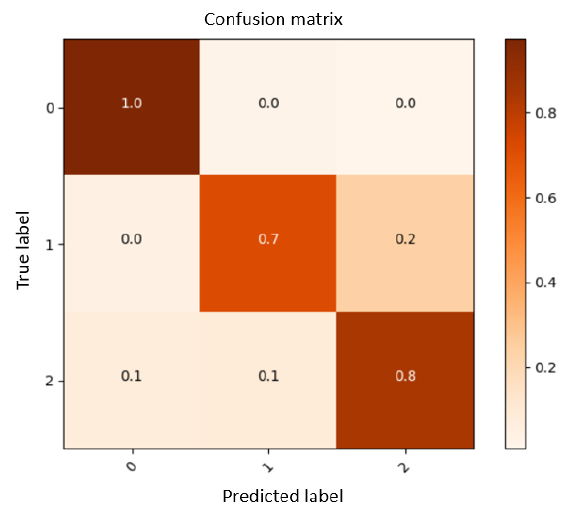
Figure 7. Confusion matrix for three gestures.